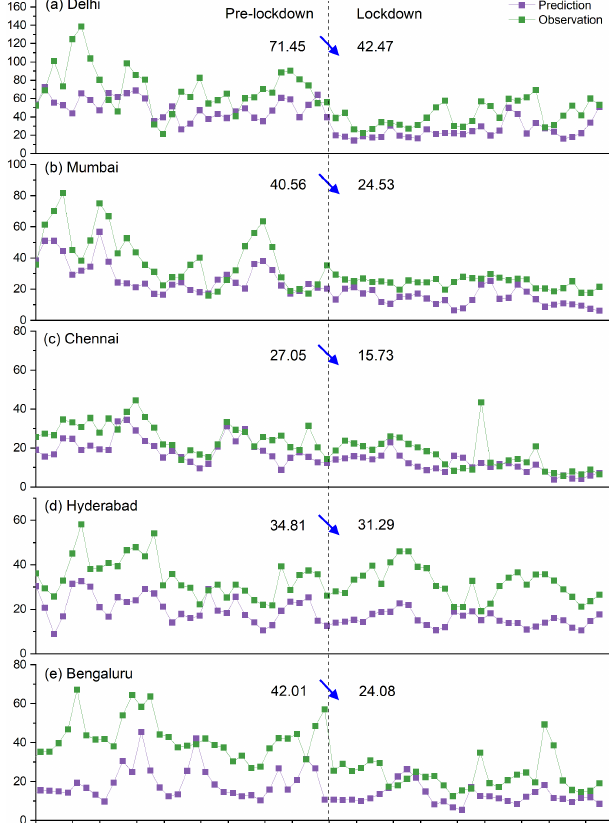
Figure 2. Comparison of predicted and observed PM 2 . 5 from 21 February to 24 April 2020 in Delhi, Mumbai, Chennai, Hyder- abad, and Bengaluru. The unit is µgm − 3